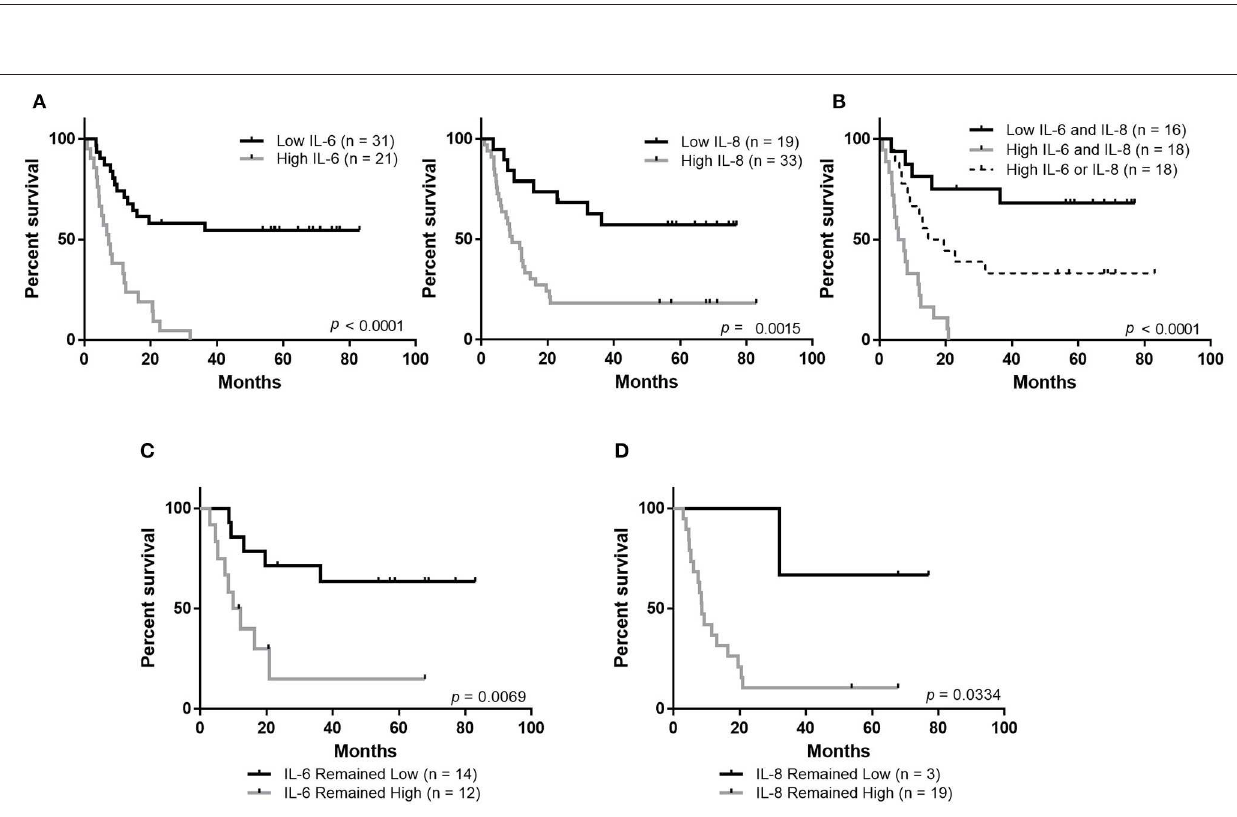
FIGURE 1 | IL-6 and IL-8 by IHC. Scale bars represent 200 µ M, green lines indicate regions identified by a trained pathologist as tumors. (D) Correlation between circulating IL-6 (top) or IL-8 (bottom) and the percentage of positive-staining tumor. Correlation between the circulating concentration of IL-6 (E) or IL-8 (F) vs. tumor burden. (G) Correlation of circulating IL-6 and IL-8, * p < 0.05.